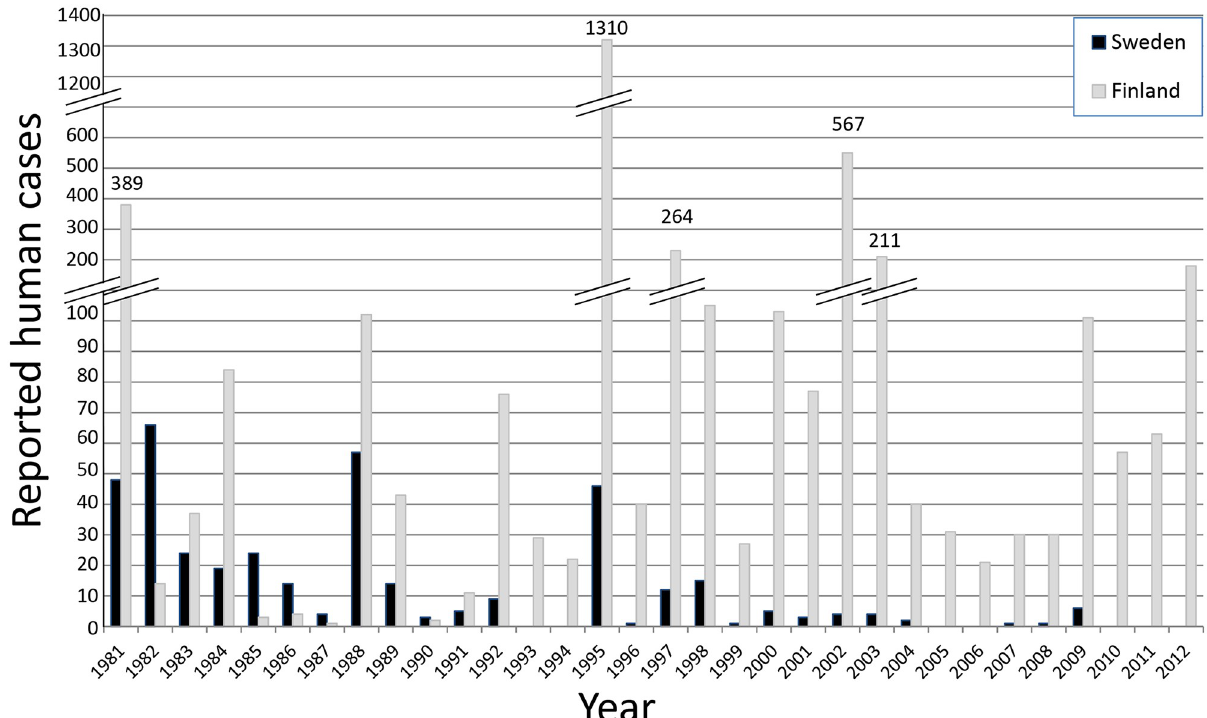
Fig 2. The number of reported and serologically confirmed clinical cases of human Sindbis virus infections 1981 to 2012 in Sweden (Ockelbo disease), and Finland (Pogosta). The considered outbreak years are 1981, 1988, 1995, 2002 and 2009, based on the suggested 7-year cycle between